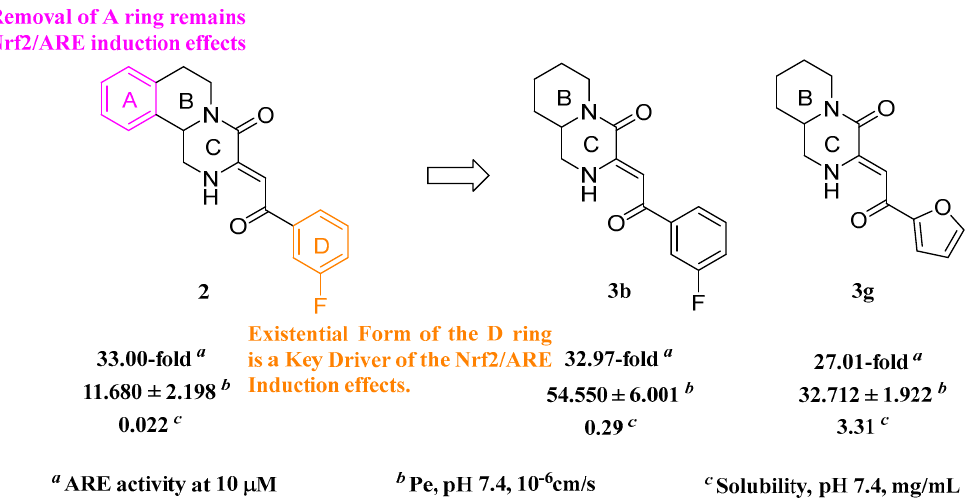
Figure 3. SAR results and developments of pyrazino[2,1- a ]isoquinolin analogue 2 and pyrido[1,2- a ]pyrazin analogues 3b and 3g